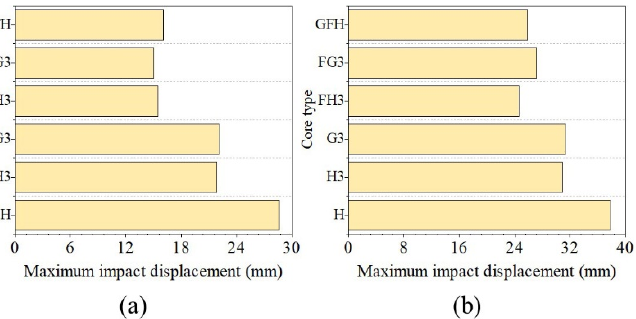
Figure 22. Maximum impact displacement of various panels with flat impactor. ( a ) Impact energy at 50 J. ( b ) Impact energy at 100